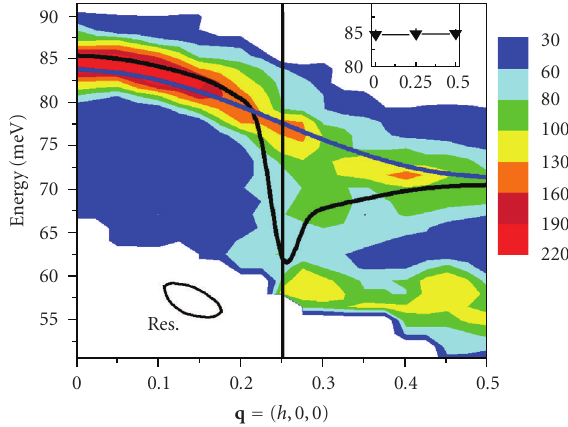
Figure 10: (a) Color-coded contour plot of the phonon spectra observed on La 1 . 875 Ba 0 . 125 CuO 4 at 10 K. The intensities above and below 60meV are associated with plane-polarized Cu–O bond- stretching vibrations and bond-bending vibrations, respectively. Lines are dispersion curves based on two-peak fits to the data. The white area at the lower left corner of the diagram was not accessible in this experiment. The ellipse illustrates the instrumental resolution. The inset shows the dispersion in the [110]-direction. The vertical line represents the charge stripe ordering wave vector. Blue/black line represents the “normal”/“anomalous” component respectively in the original interpretation of the authors. Subse- quent work showed that a substantial part of the intensity in the “normal” component is an artifact of finite wavevector resolution in the transverse-direction (out of the page) [36].